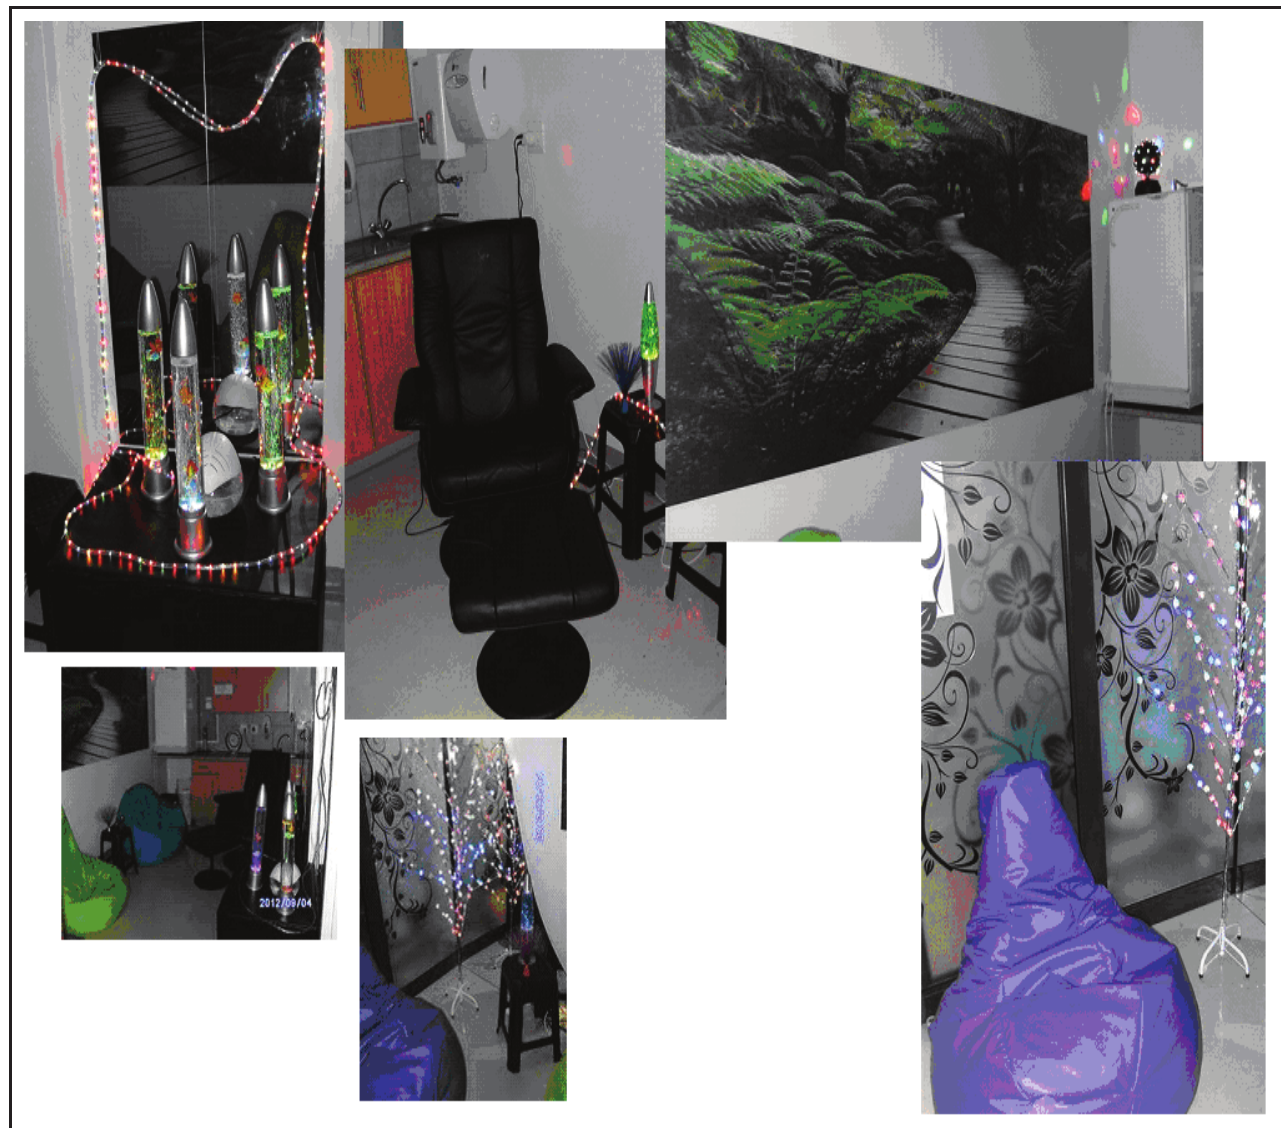
FIGURE 1: Sensory stimulation room in the operating room